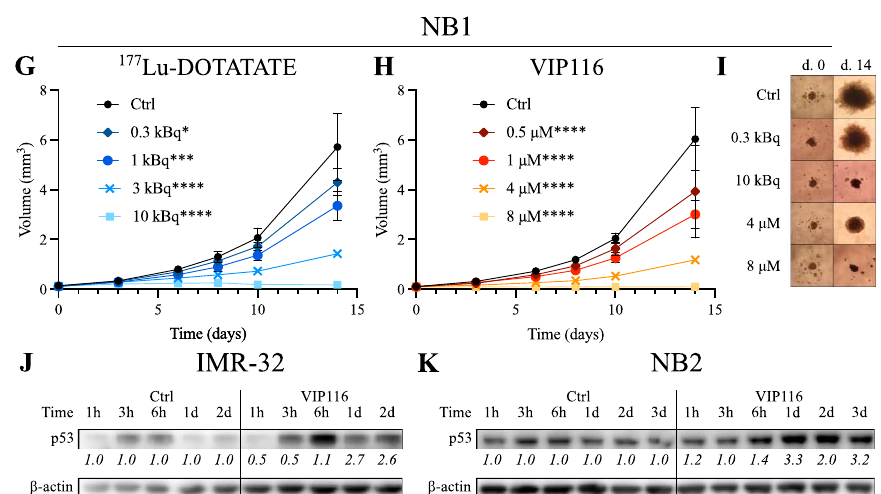
Figure 2. Spheroid monotherapy. Graphs from one representative experiment (mean ± SD, n ≥ 4). Scale bar on spheroid images = 500 μm. ( A ) 177 Lu-DOTATATE monotherapy of IMR-32. ( B ) VIP116 monotherapy of IMR-32. ( C ) Representative IMR-32 spheroid images at days 0 and 14. ( D ) 177 Lu- DOTATATE monotherapy of NB2. (E) VIP116 monotherapy of NB2. ( F ) Representative NB2 spheroid images at days 0 and 12. ( G ) 177 Lu-DOTATATE monotherapy of NB1. ( H ) VIP116 monotherapy of NB1. ( I ) Representative NB1 spheroid images at day 0 and 14. ( J ) Representative Western blot of VIP116-treated IMR- 32 spheroids. Intensity value for p53 were normalized to β -actin and corresponding control band for each time point. ( K ) Representative Western blot of VIP116-treated NB2 spheroids . Intensity value for p53 were normalized to β -actin and corresponding control band for each time point. n.s. = not significant, * = p < 0.05, ** = p < 0.01, *** = p < 0.001 and **** = p < 0.0001.